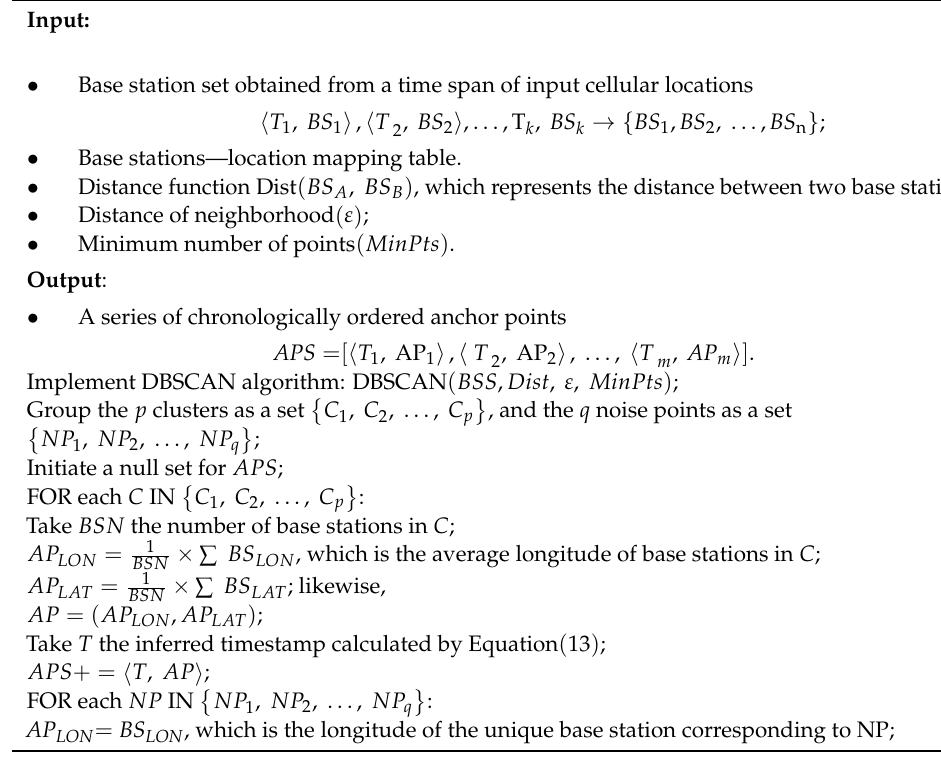
Algorithm 1. Anchor point location capture and its timestamp inference.